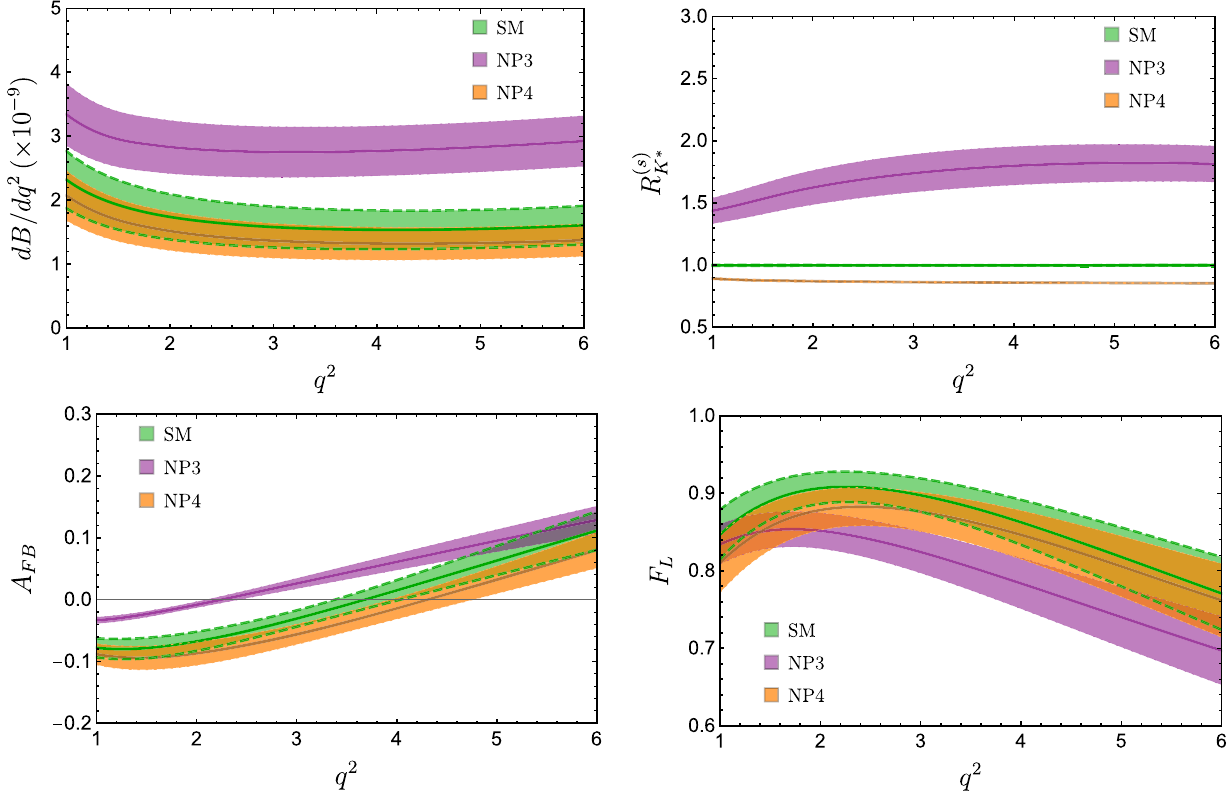
Fig. 6 The predictions for B s → ¯ K ∗ μ + μ − decay, with complex Z (cid:3) couplings, for SM and the benchmark scenarios NP3 and NP4 as given